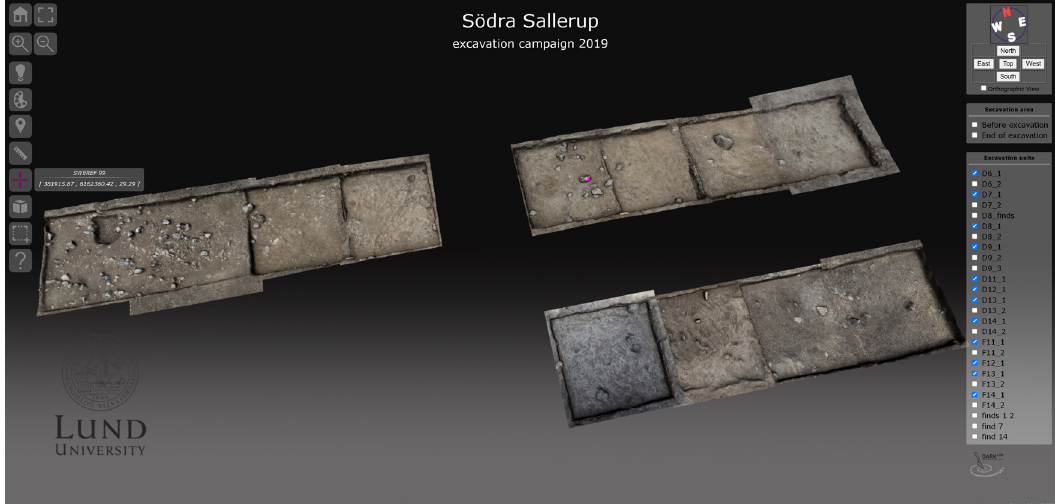
Figure 1: The 2019 interactive visualisation system of Södra